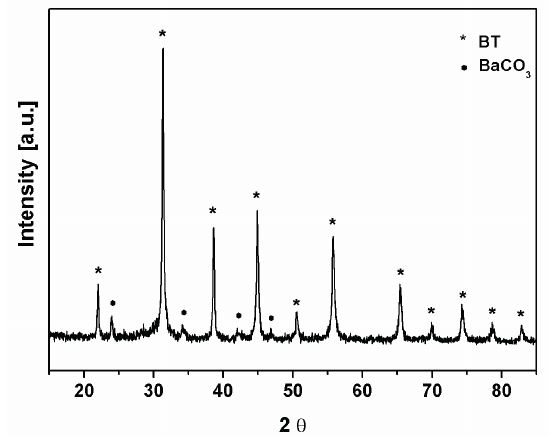
Figure 7. X-ray diffractogram of the BBT powder.